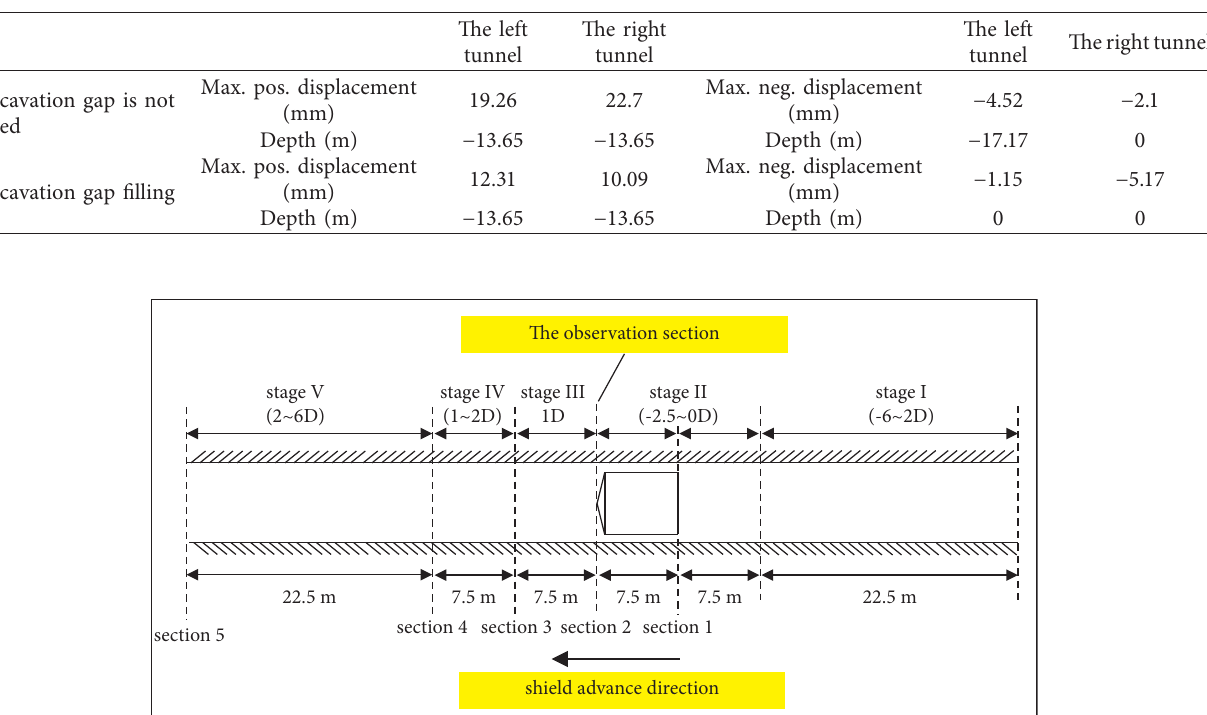
Table 3: Lateral displacement of the deep stratum.